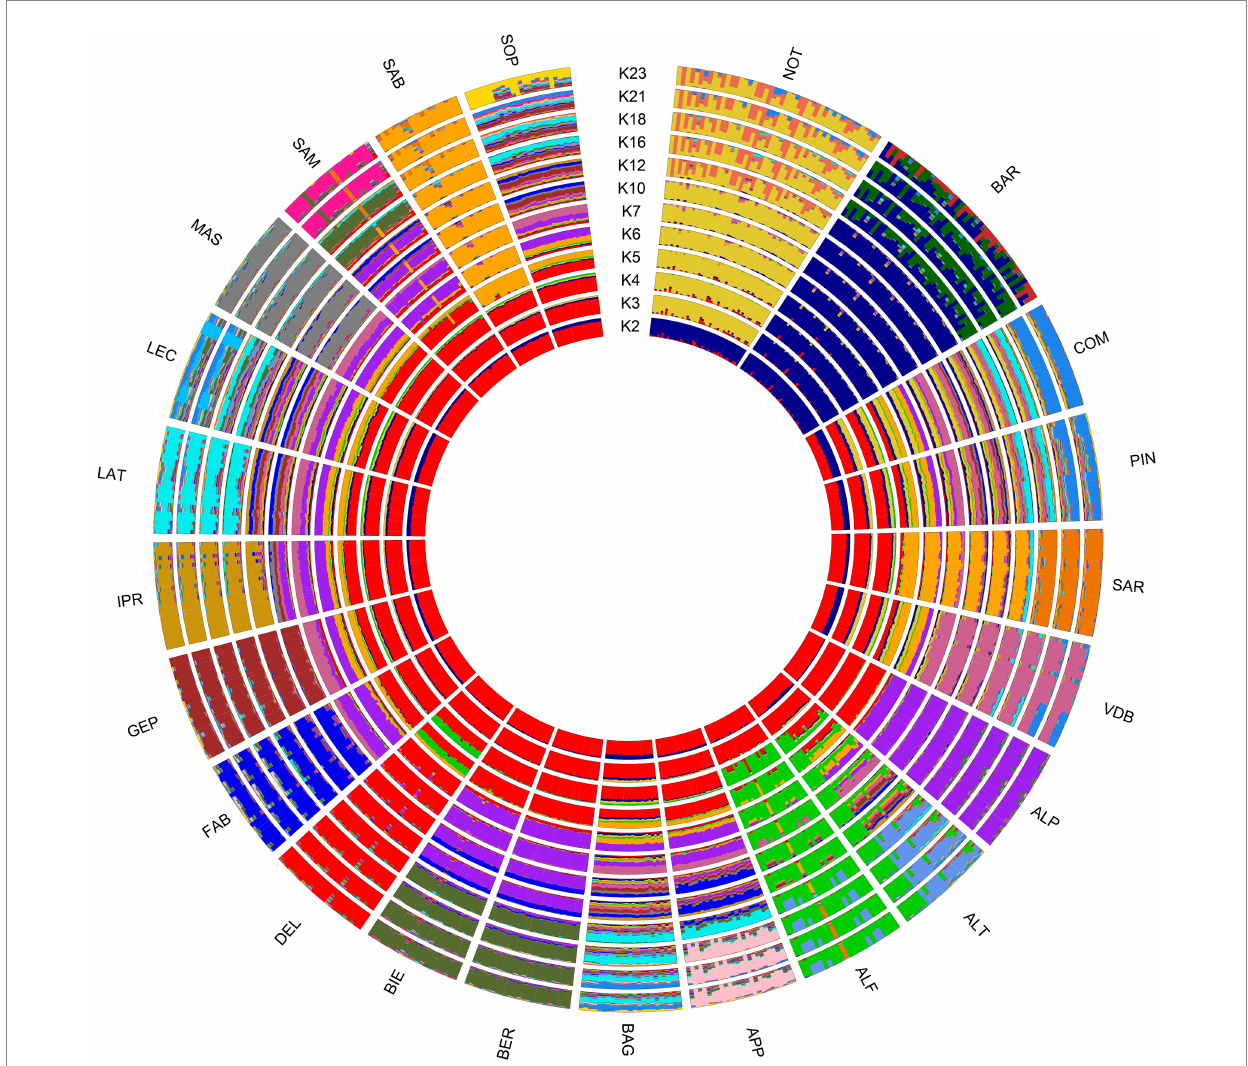
FIGURE 5 Circle plot showing ancestral clusters (K) inferred by the Admixture analysis of 23 sheep breeds. For full definition of the breeds, see Table